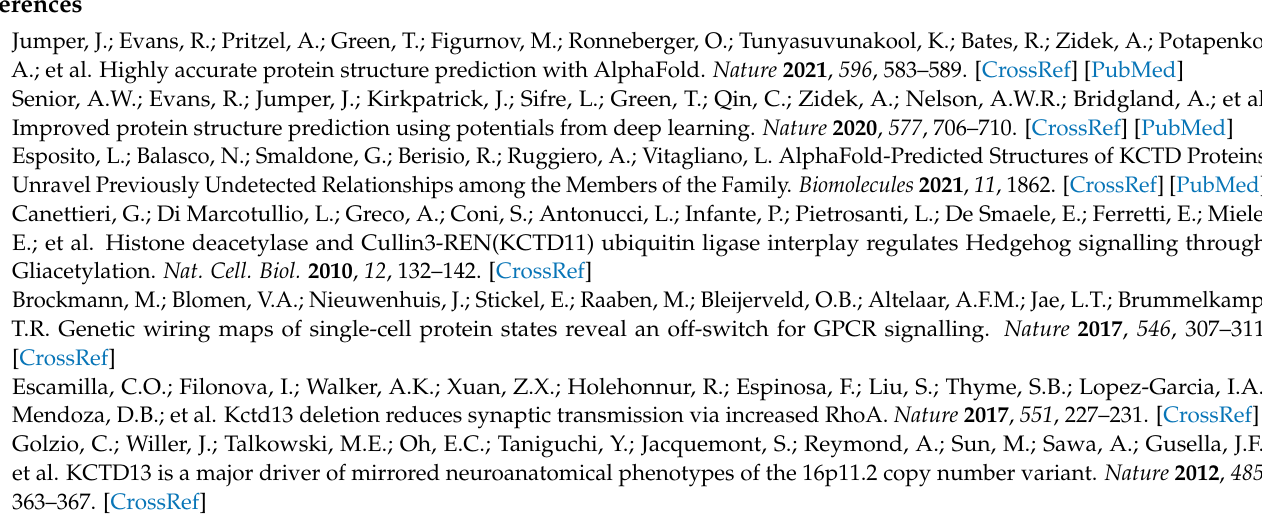
of KCTD; Figure S2: PAE matrices of the BTB domains of KCTD proteins in the pentameric state; Figure S3: PAE matrices of all reliable pentamers of full-length KCTDs; Figure S4: PAE matrices and unreliable structures of pentameric assemblies of full-length KCTDs; Figure S5: Quantification of the reliability of the predictions through the analyses of the matrices: KCTD6 as example; Figure S6: Schematic representation of AF structures of members of Cluster 1; Figure S7: KCTD8 protein; Figure S8: KCTD16 protein; Figure S9: Schematic representation of AF structures of members of Cluster 3; Figure S10: Structural superimposition of the CTDs of members of sub-Cluster 5B; Figure S11: AF model of KCTD9 sequence including the N-terminal ubiquitin-like domain and the BTB domain; Figure S12: Schematic representation of the AF model of full-length KCTD9 with a reduced CTD; Figure S13: PAE matrices of Cluster 6 dimers; Figure S14: Structure stability of the pentameric AF model of KCNRG in the MD simulation; Figure S15: Structure stability of the pentameric AF model of KCTD6 in the MD simulation; Figure S16: Structure stability of the pentameric AF model of KCTD11 in the MD simulation; Figure S17: Structure stability of the pentameric AF model of KCTD21 in the MD simulation; Figure S18: Structure stability of the pentameric AF model of KCTD4 in the MD simulation; Figure S19: Structure stability of the pentameric AF model of KCTD7 in the MD simulation; Figure S20: Structure stability of the pentameric AF model of KCTD14 in the MD simulation; Figure S21: Structure stability of the dimeric AF model of KCTD13 in the MD